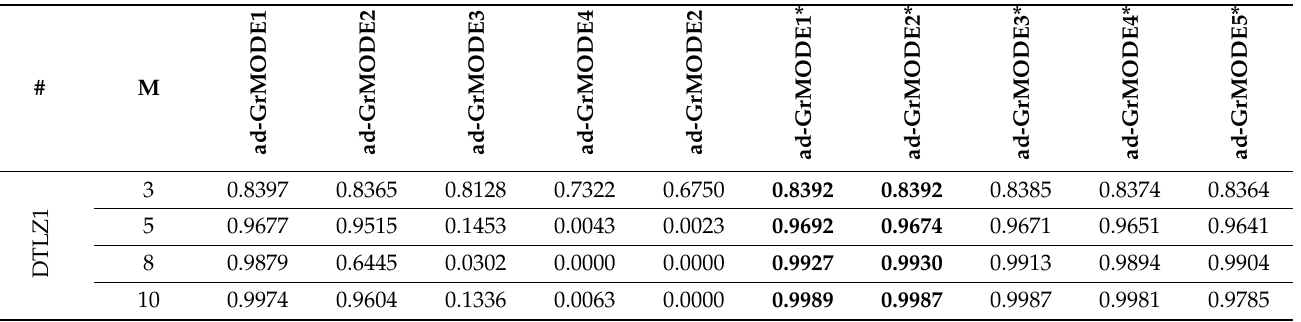
Table A1. The mean values of the HV indicator for different grid settings of the proposed algorithm on